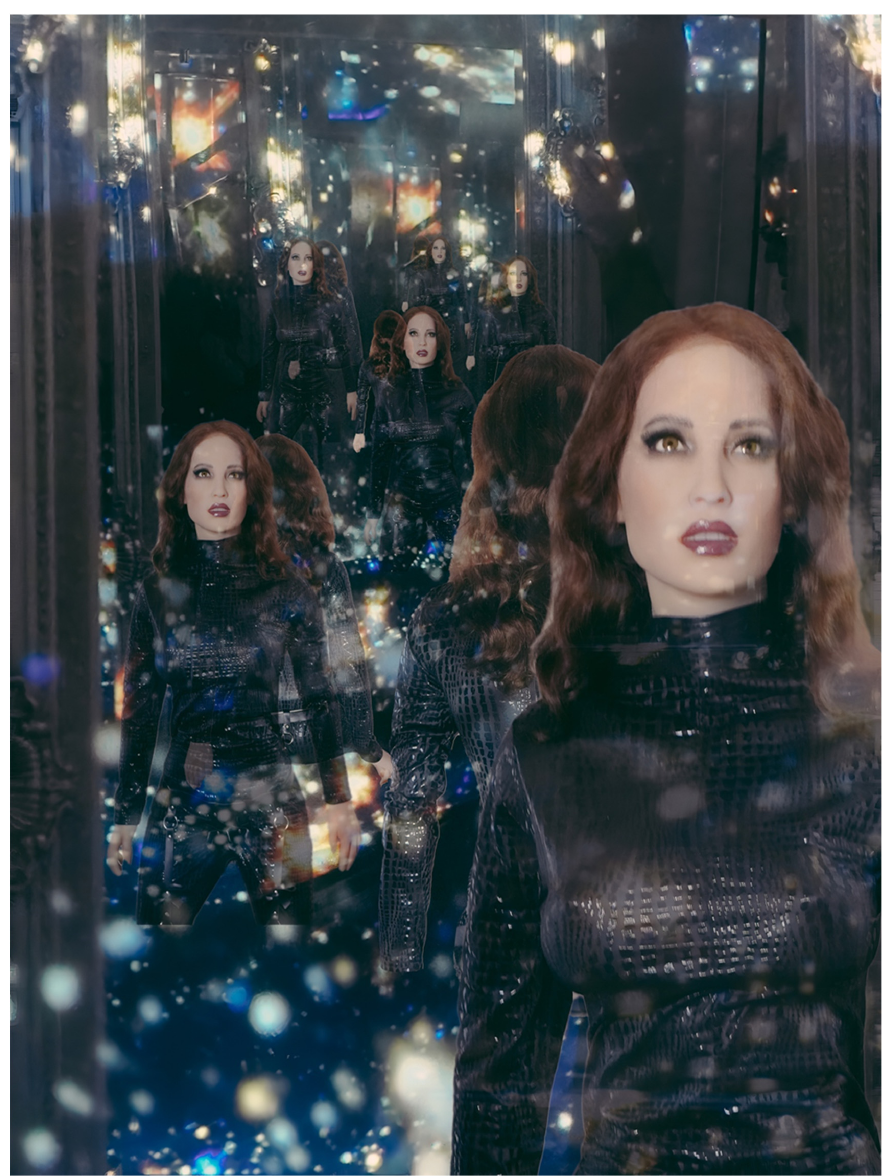
Figure 10. Madeleine + I do not accept finity. By Graeme Revell, 2022. Photograph, GPT-2/DALL-E2 image and text.